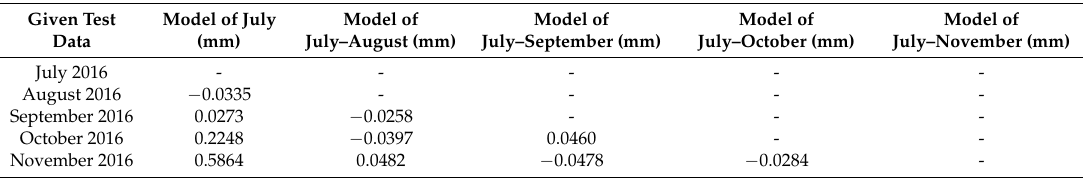
Table 7. ACE values with respect to the test